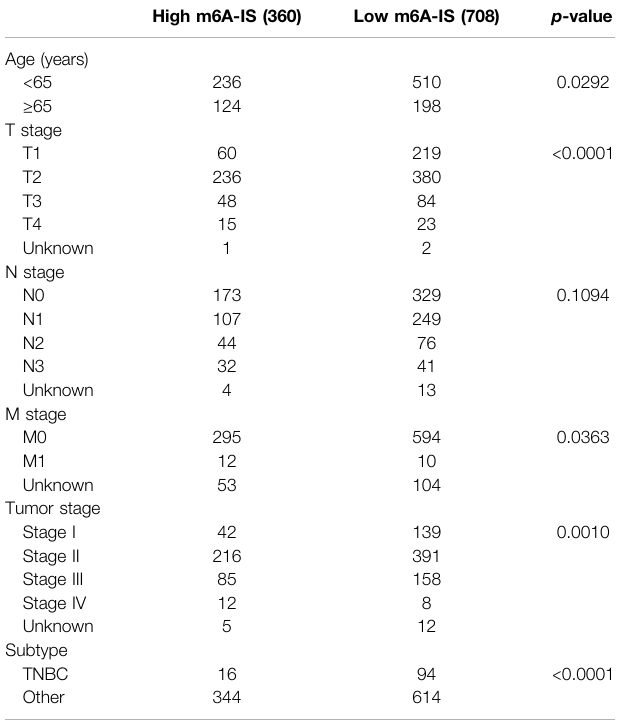
TABLE 1 | Clinical characteristics of the high- and low-m6A-IS groups High m6A-IS